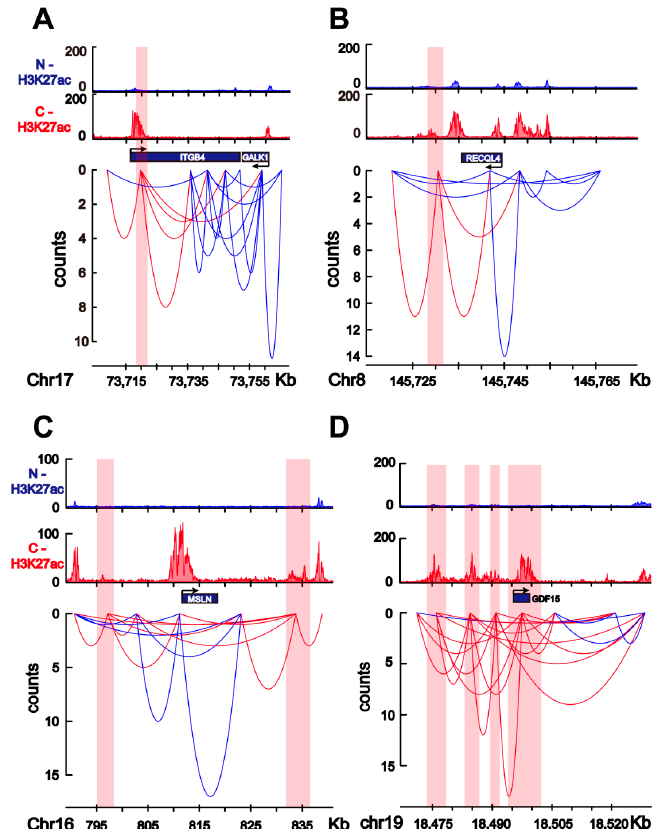
Figure 6. Target genes of the colorectal-cancer-specific enhancers. ( A ) H3K27ac enrichment for normal colon cells (N; blue) and colorectal cancer cells (C; red), as well as HiChIP interaction loops (red curves) between the ITGB4 target gene and colorectal-cancer-specific enhancers. Colorectal- cancer-specific enhancers are shaded in red. Blue curves indicate other interaction loops in this area. ( B ) H3K27ac enrichment for normal colon cells (N; blue) and colorectal cancer cells (C; red), as well as HiChIP interaction loops (red curves) between the RECQL4 target gene and colorectal-cancer-specific enhancers. The colorectal-cancer-specific enhancers are shaded in red. Blue curves indicate other interaction loops in this area. ( C ) H3K27ac enrichment for normal colon cells (N; blue) and colorectal cancer cells (C; red), as well as HiChIP interaction loops (red curves) between the MSLN target gene and colorectal-cancer-specific enhancers. Colorectal-cancer-specific enhancers are shaded in red. Blue curves indicate other interaction loops in this area. ( D ) H3K27ac enrichment for normal colon cells (N; blue) and colorectal cancer cells (C; red), as well as HiChIP interaction loops (red curves) between he GDF15 target gene and colorectal-cancer-specific enhancers. Colorectal-cancer-specific enhancers are shaded in red. Blue curves indicate other interaction loops in this